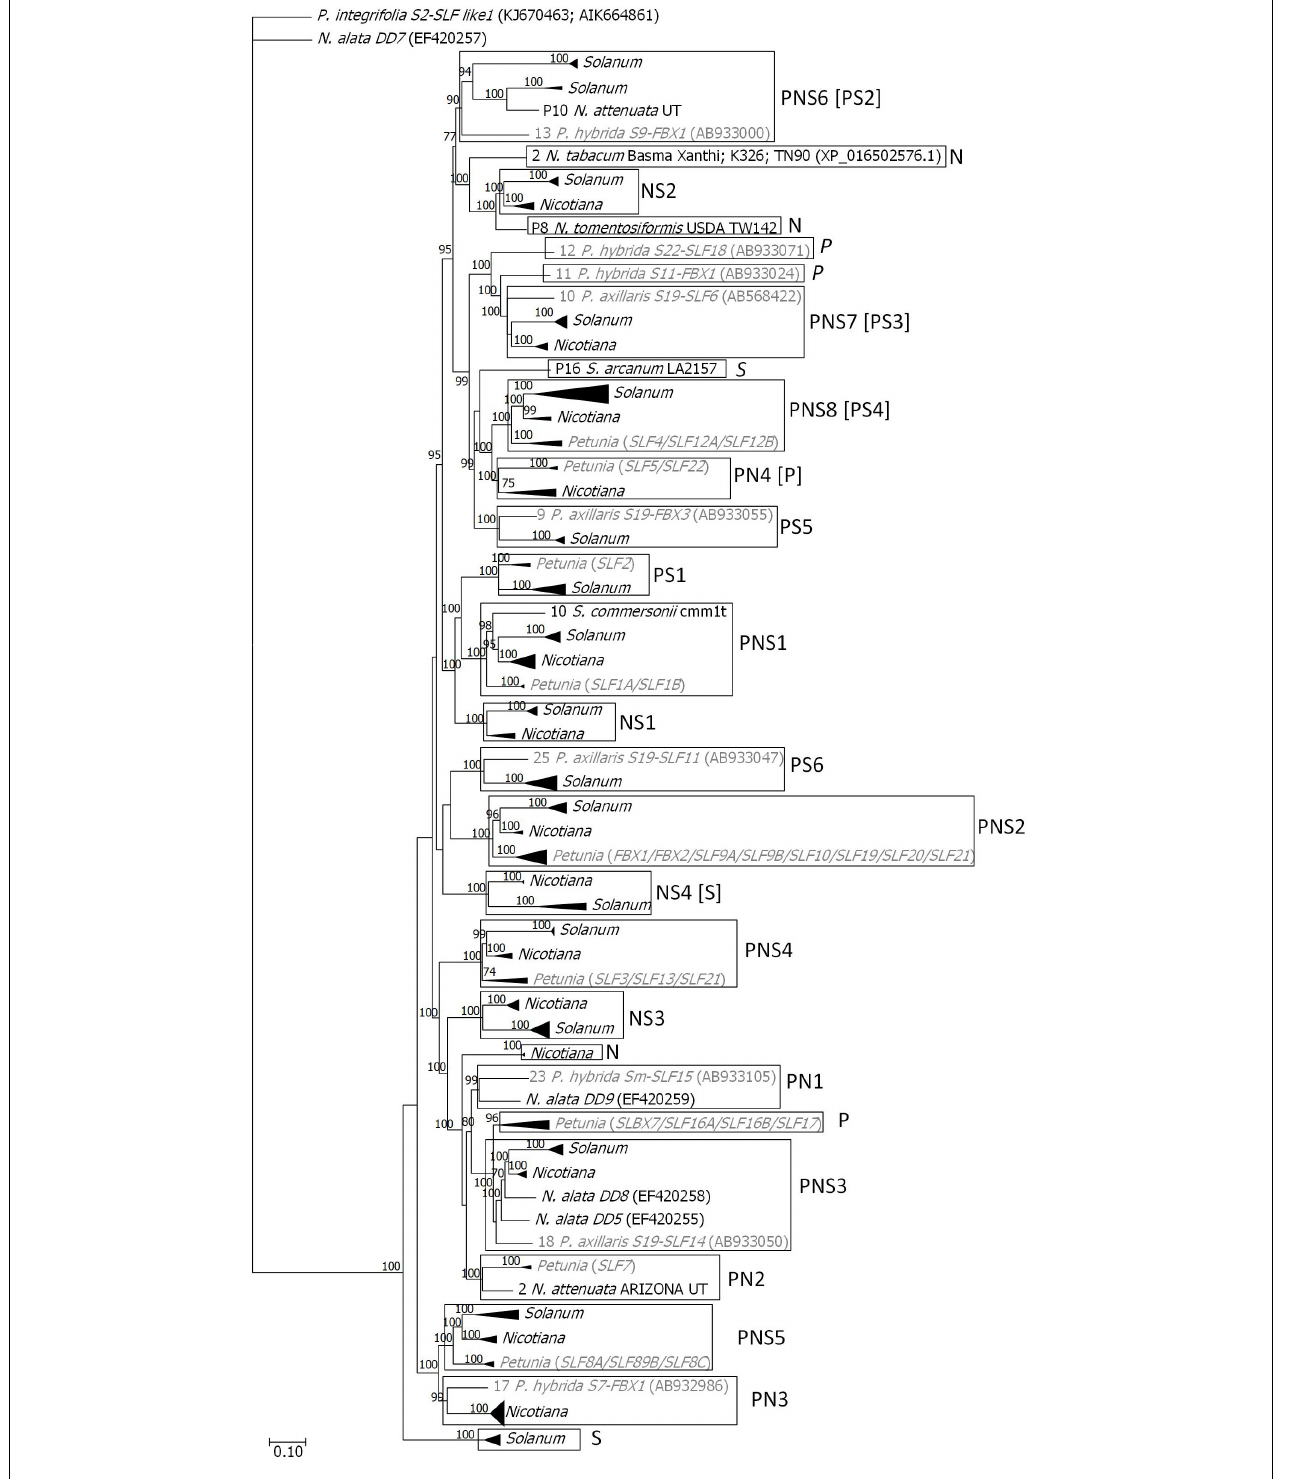
FIGURE 1 | Bayesian phylogenetic tree showing the relationship of the Petunia , Solanum , and Nicotiana SLF sequences, used to infer gene lineages. The tree was rooted with P. integrifolia S2-SLFlike1 (KJ670463; AIK66486). For Petunia (in gray) only one sequence for each SLF gene (1–36; Supplementary Figure S1 ) was used. Squares represent gene lineages, and P, N, and S are used to identify if the gene lineage is present in Petunia , Nicotiana , and Solanum , respectively. In square brackets is the characterization of each gene lineage when pseudogenes are not considered ( Supplementary Figure S2 ). Numbers above the branches represent posterior credibility values above